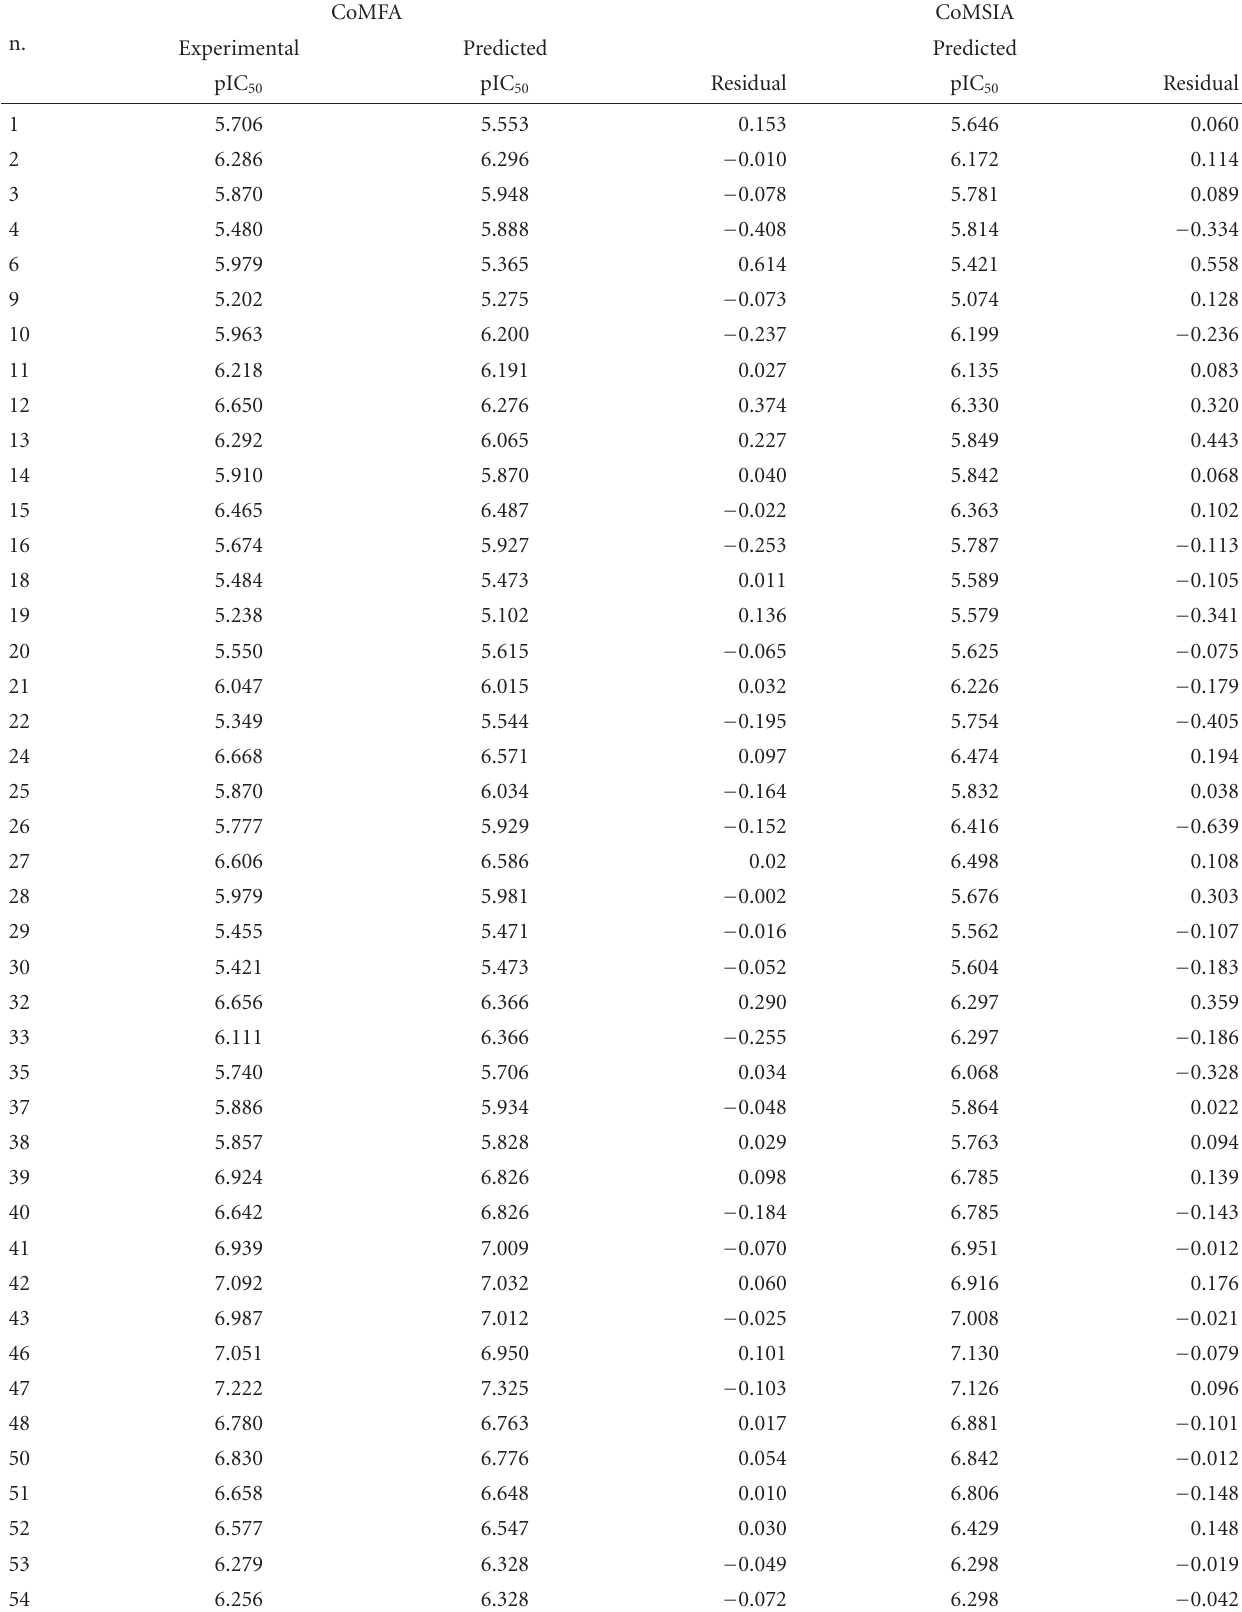
Table 4: Experimental and predicted activities with their residuals by CoMFA and CoMSIA analyses of the training set. CoMFA CoMSIA n. Experimental Predicted Predicted pIC 50 pIC 50 Residual pIC 50